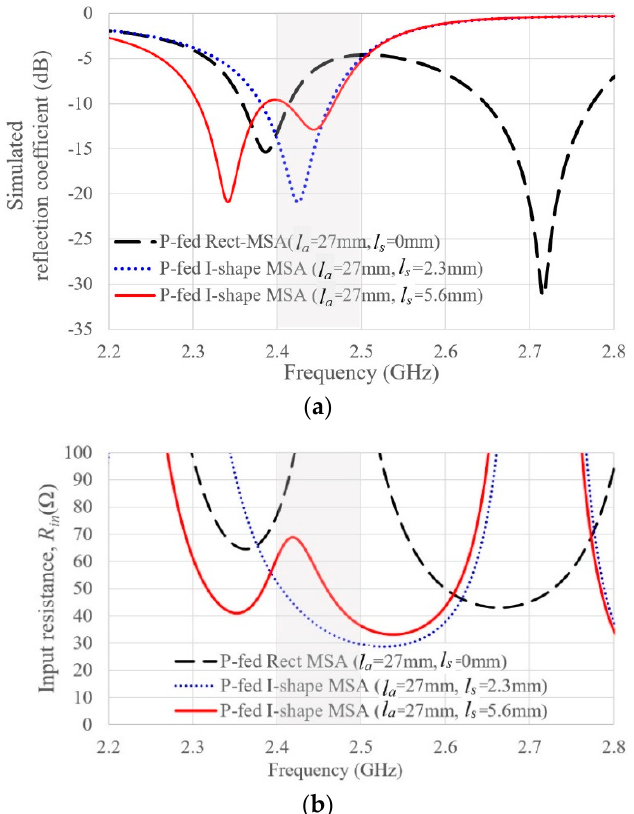
Figure 3. Length l s is adjusted to bring input resistance of P-fed I-shape MSA close to 50 Ω at 2.45 GHz ISM band, after P-fed Rect-MSA in dashed black line ( g = 0.5 mm, l a = 31 mm, l s = 0 mm) is miniaturized to become P-fed I-shape MSA ( g = 0.5 mm, l a = 27 mm, l s varies from 2.3 mm to 5.6 mm). ( a ) Simulated reflection coefficient; ( b ) Input resistance R in .